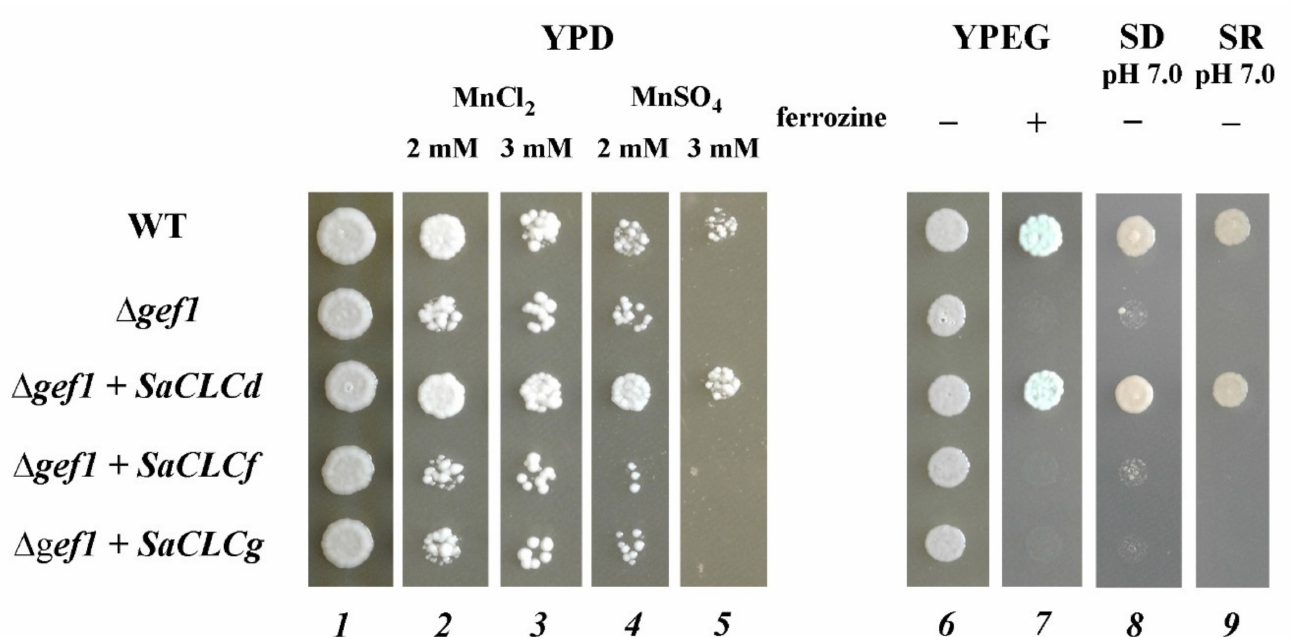
Figure 3. The growth of the yeast mutant ∆ gef1 transformed with SaCLCd , SaCLCf , and SaCLCg genes. Controls: wild-type W3031A and the mutant ∆ gef1 transformed with vector pMB1. Selective